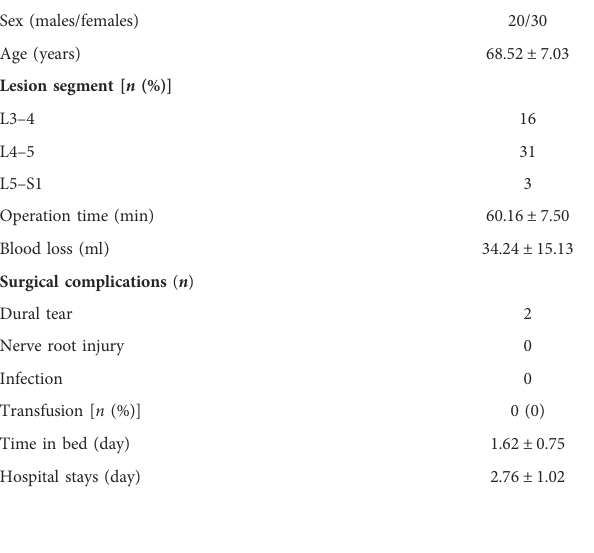
TABLE 3 Imaging